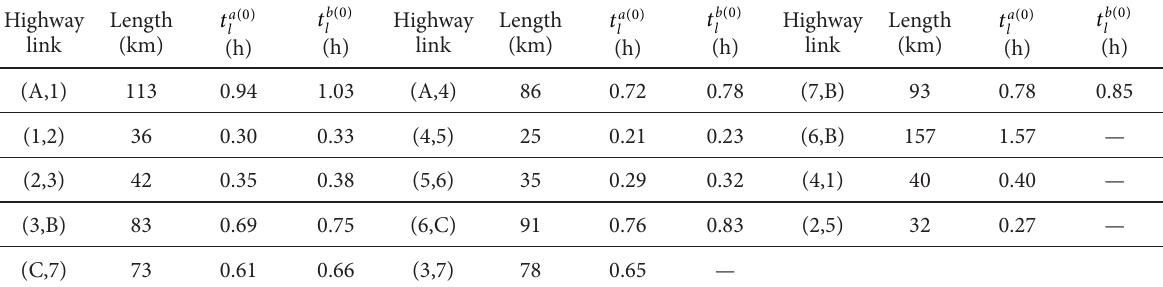
Table 1. Parameters of the intercity bus link and private veh icle link travel time